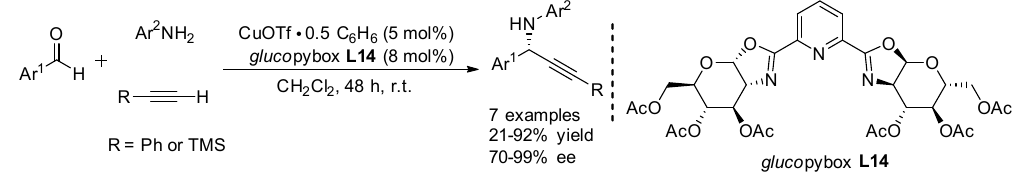
Figure 7. Cu(I)/ gluco Pybox-catalyzed AA 3 -couplings.